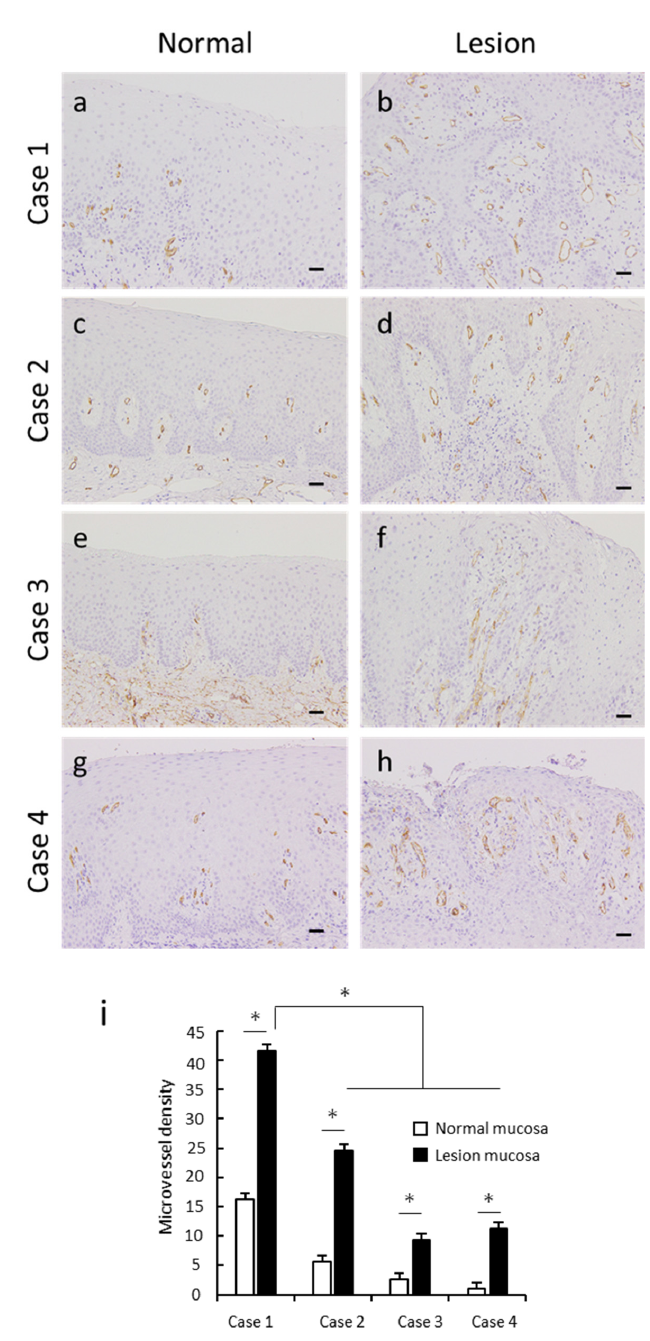
Figure 3. Angiogenesis in oral verruciform xanthoma. Representative CD34 images of oral verruciform xanthoma. ( a , c , e , g ) Few CD34-postive capillaries and small vessels with lumens were observed in the normal mucosa of all patients. ( b , d , f , h ) Vascularization of several elongated small blood vessels was observed in the connective tissue papillae in the lesioned mucosa of all patients (scale bar, 50 µ m; original magnification, 200 × ). ( i ) Microvessel density (MVD) of all oral verruciform xanthoma cases was significantly higher than that of the corresponding normal epithelia. MVD was evaluated within 100 µ m of the stroma from the superficial epithelium. The MVD of verrucous-type OVX was higher than that of the flat-type cases. CD34-postive capillaries and small vessels with lumens were selected, and the numbers of microvessels were counted as MVD (per 200 × field). * p < 0.05 by t